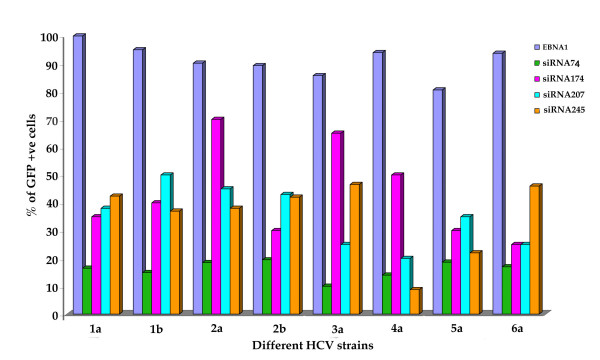
Quantitative measurement of GFP positive Huh-7 cells by flow cytometry after siRNA transfection. Huh-7 cells were co-transfected with HCVIRES-GFP plasmid with siRNA plasmid (pSuper-retro) by using the FuGENE 6 transfection reagent. After 48 hours of transfection, cells were harvested and GFP positive cells were analysed by a flow cytometer (Becton Dickinson, BD Biosciences, Clontech). Percentage of GFP-positive Huh-7 cells was quantitatively determined after siRNA transfection using cell quest computer software. The results were expressed as percentage of control. siRNA-74 was found to be most effective in silencing GFP from all IRES clones.